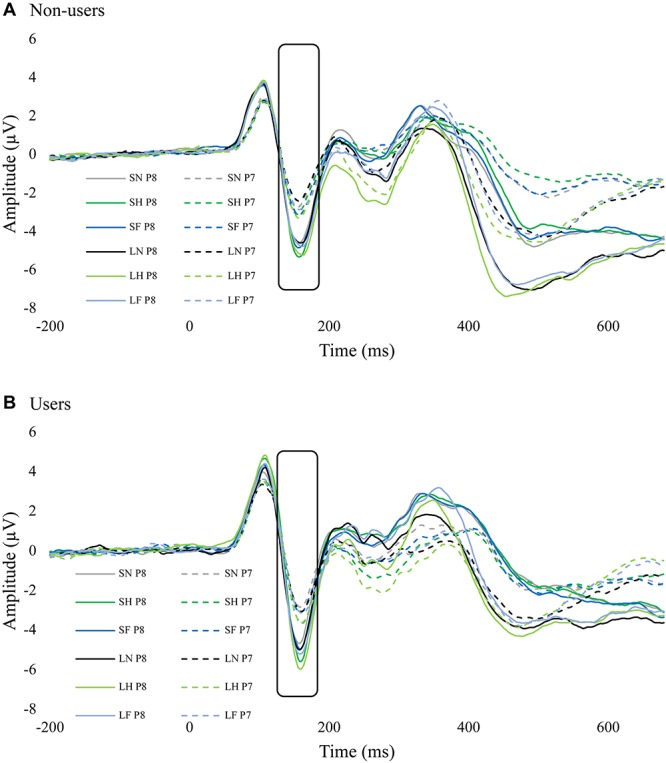
ERP waves from P7 and P8 for each group. These two figures display the ERP waveforms from electrodes P7 and P8 for non-users (A) and cannabis users (B). There was significant hemisphere lateralization in non-users but not in users. SF, short fear; SH, short happy; SN, short neutral; LF, long fear; LH, long happy; and LN, long neutral.